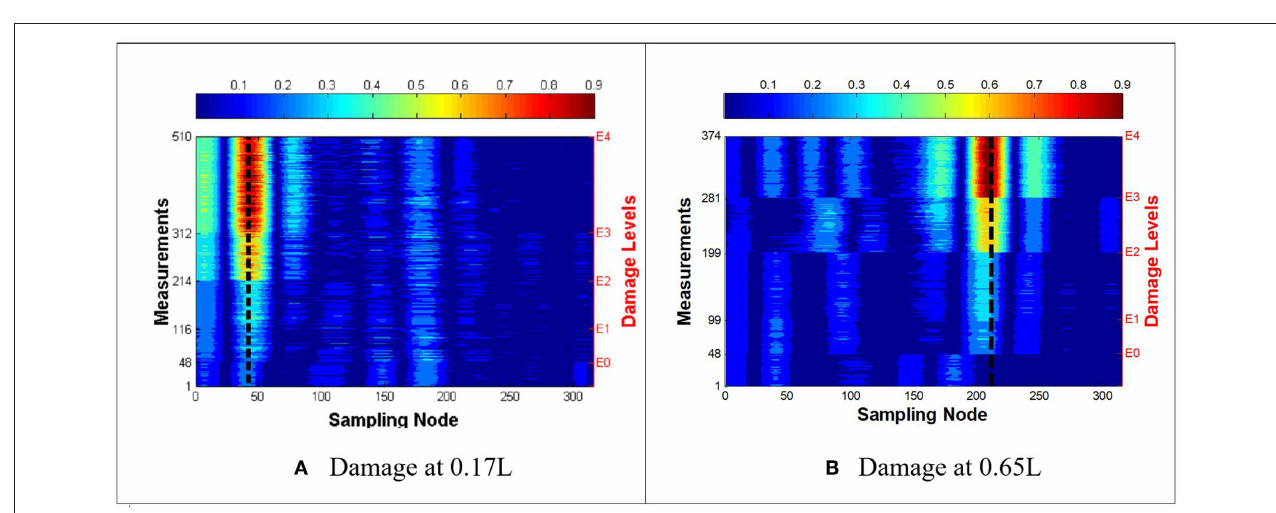
FIGURE 7 | Wavelet coefficients as a function of damage levels E0 through E4 for damage at (A) 0.17L and (B) 0.65L (Shahsavari, 2017).